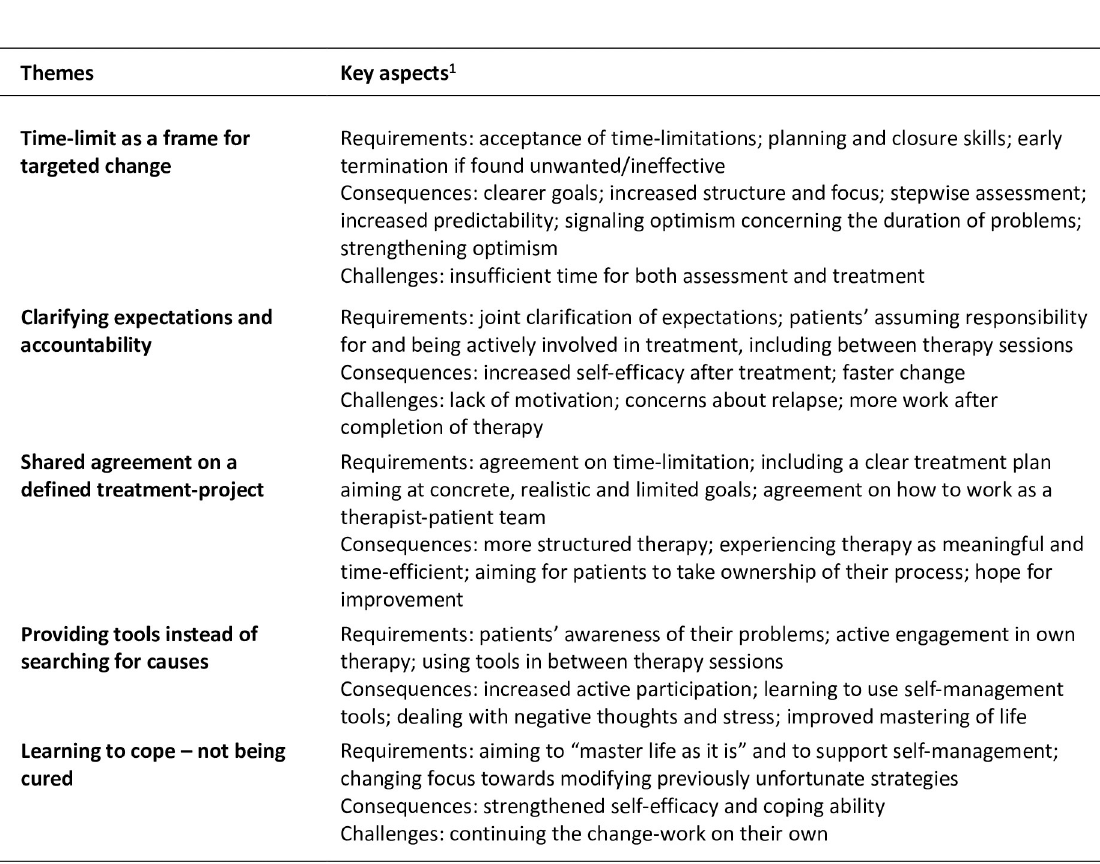
Fig 2. Themes with key aspects. 1. The different key aspects describing themes could include requirements, consequences, and challenges.